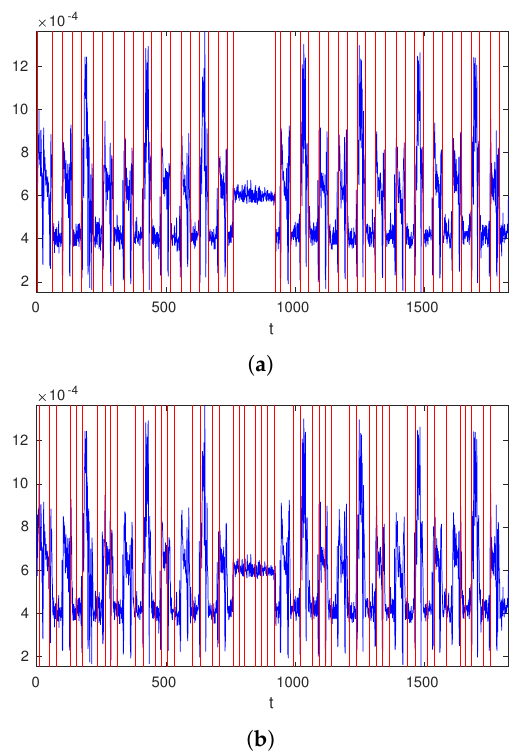
Figure 8. Comparison of two methods. ( a ) Proposed method; ( b ) Naive peak detection method.